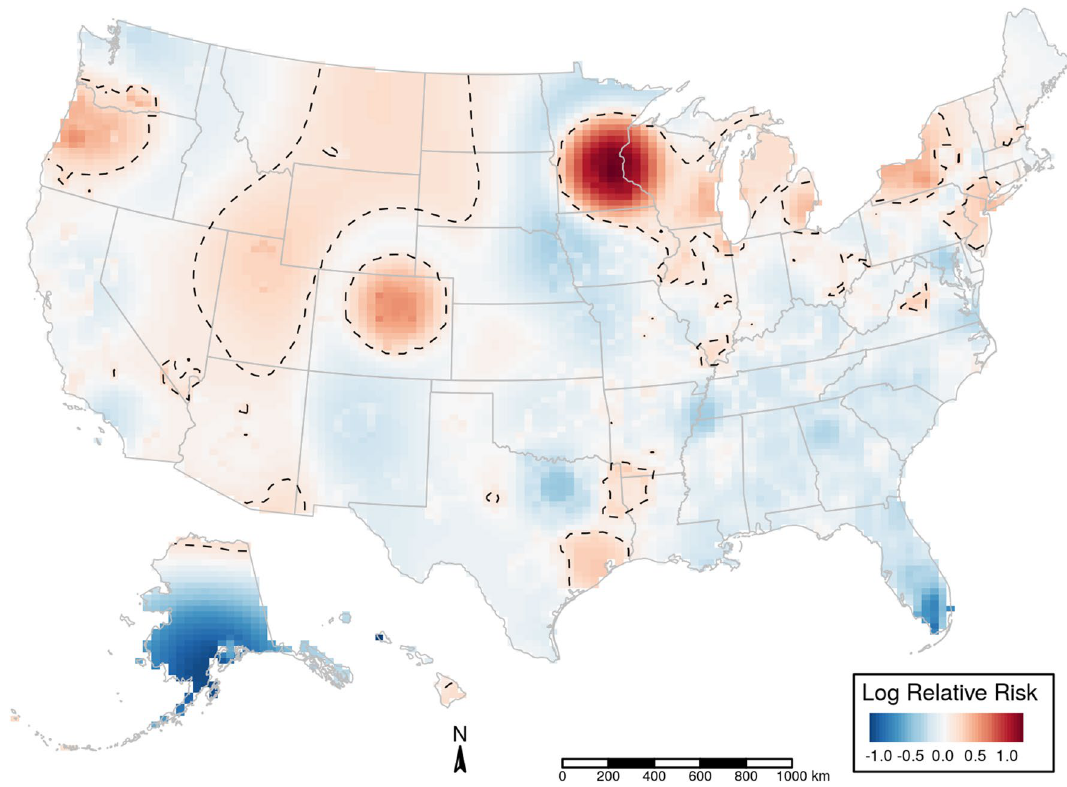
Figure 3. Spatial relative risk of gun violence during the pandemic vs. pre-pandemic. Map shows the intensity (or risk) difference which was estimated by comparing the smoothed intensity of GV events during the pandemic (March 01, 2020, through March 31, 2021) vs. before the pandemic (February 01, 2019, through February 29, 2020) across 51 states. If the difference is ~ 0, the risk of GV is unrelated to spatial location. Evidence of spatial variation in risk occurs where the intensities differ. Difference values > 0 indicate higher risk, and values < 0 indicate lower risk. Dotted lines highlight areas of significantly higher risk of GV during the